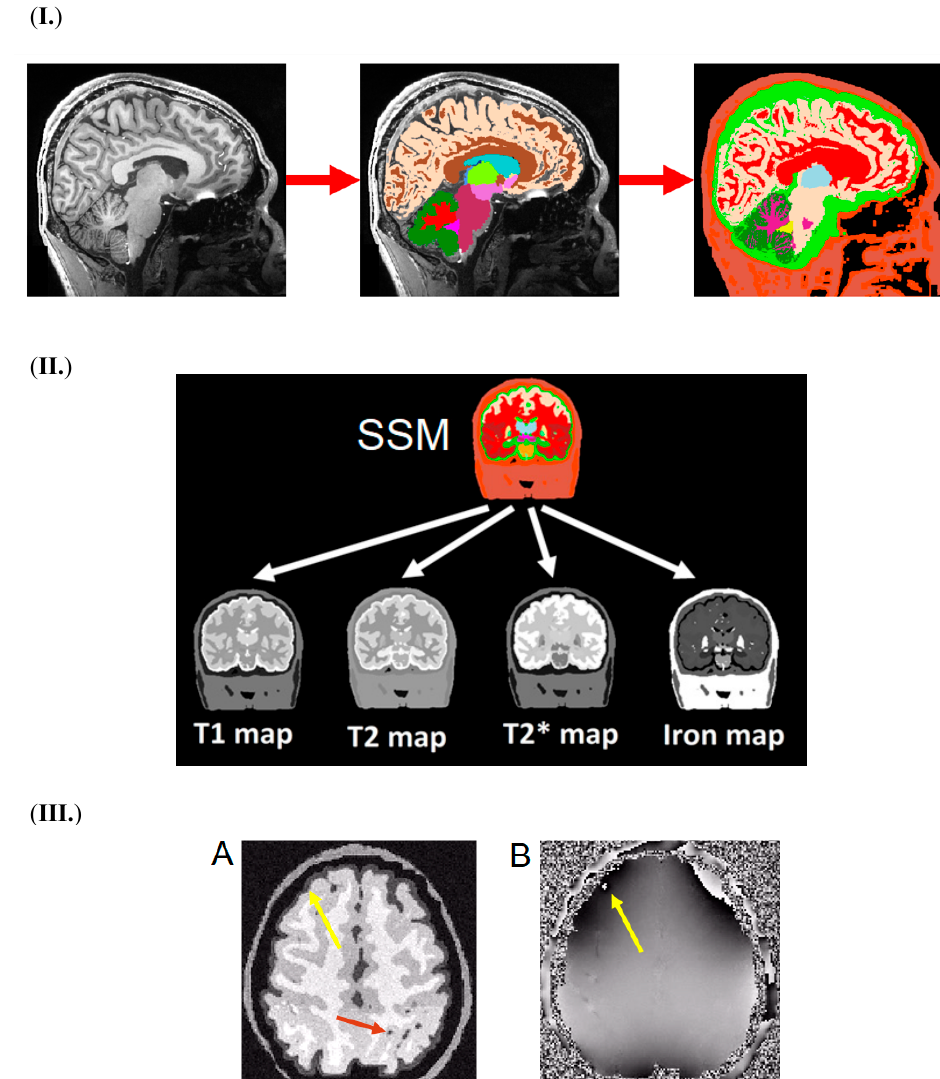
Figure A7. ( I ) Root Segmentation Map (RSM) process. Colors indicate unique segmented brain and head regions. ( II ) Applying unique EMTP tissue properties. Each segment has a defined range of ground truth EMTP tissue properties that are selected when creating the SSM. ( III ) MRI Simulator output. A shows the magnitude image, and B shows the phase image. The yellow arrow indicates a microbleed, while the red arrow indicates arterial vessels. The microbleed is easily detected in the phase, as opposed to the magnitude image.